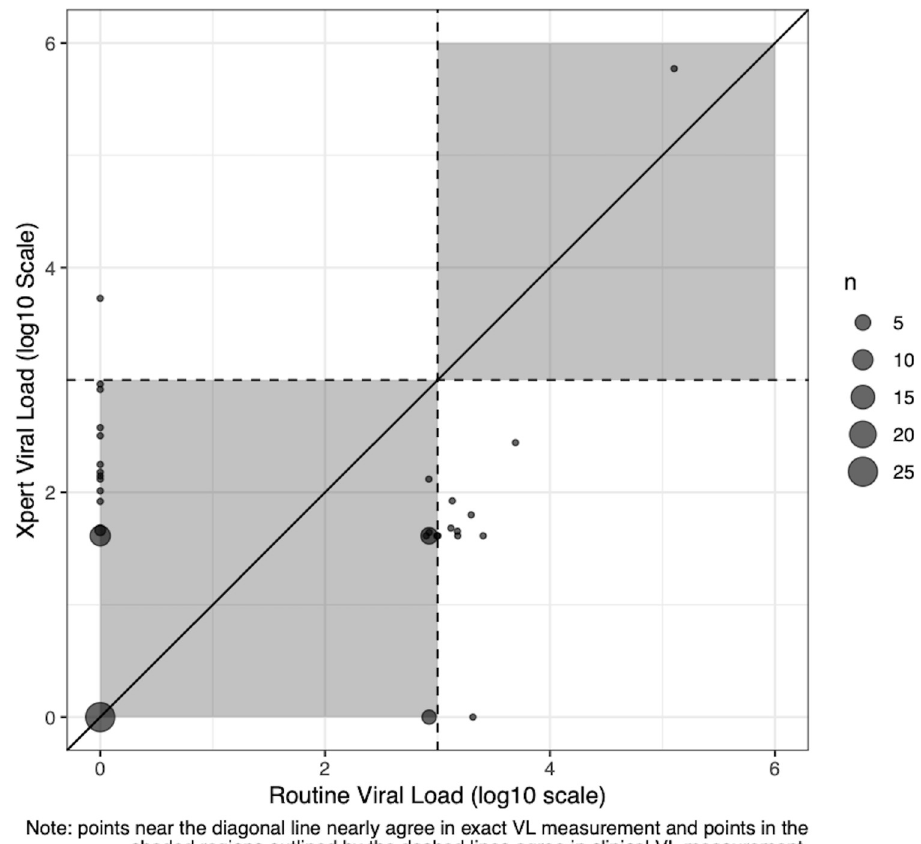
Fig 4. Results of paired Xpert and routine HIV VL testing. Clinically relevant threshold of 1,000 copies/mL indicated by dashed lines. Points falling within the same quadrant would represent cases where clinical management would be same based on either Xpert or routine